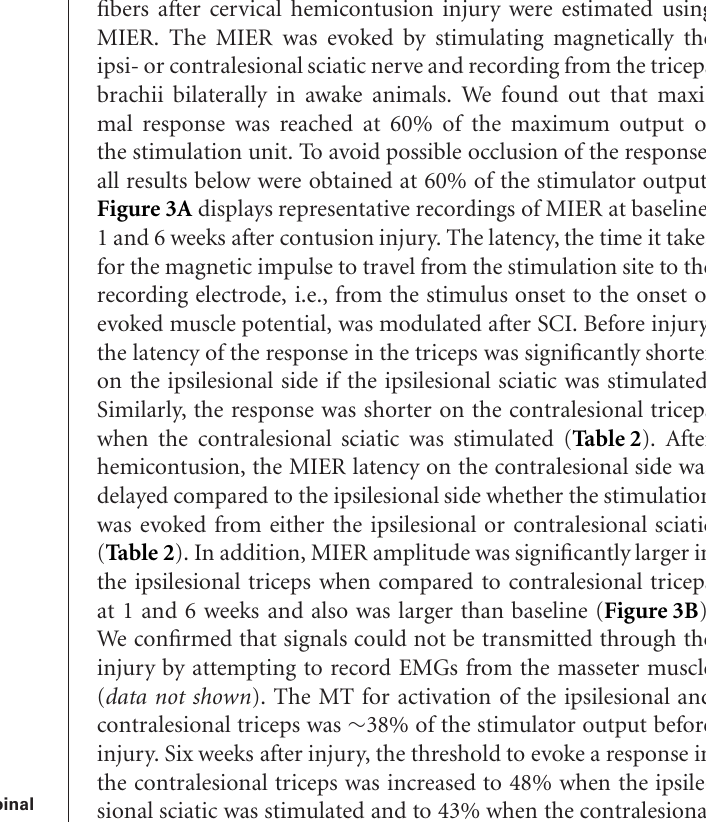
FIGURE 2 | Anatomical and behavioral evaluation of unilateral spinal cord contusion. (A) Representative transverse section of the lesion epicenter stained for Nissl and myelin. 200k dyne impact produced a unilateral lesion with a spared rim of lateral white matter on the right side of the spinal cord, while the gray and white matter of the contralesional spinal cord appears normal (scale bar = 0.5mm). (B) Assessment of the ipsilesional forelimb with the Forelimb Locomotor Scale (FLS) revealed significant deficits in ipsilesional forelimb function acutely after SCI that partially recovers over time. (C) Unilateral SCI produced significant, bilateral deficits in hindlimb locomotor function in the open field as assessed by the Basso, Beattie, Bresnahan (BBB) Locomotor Rating